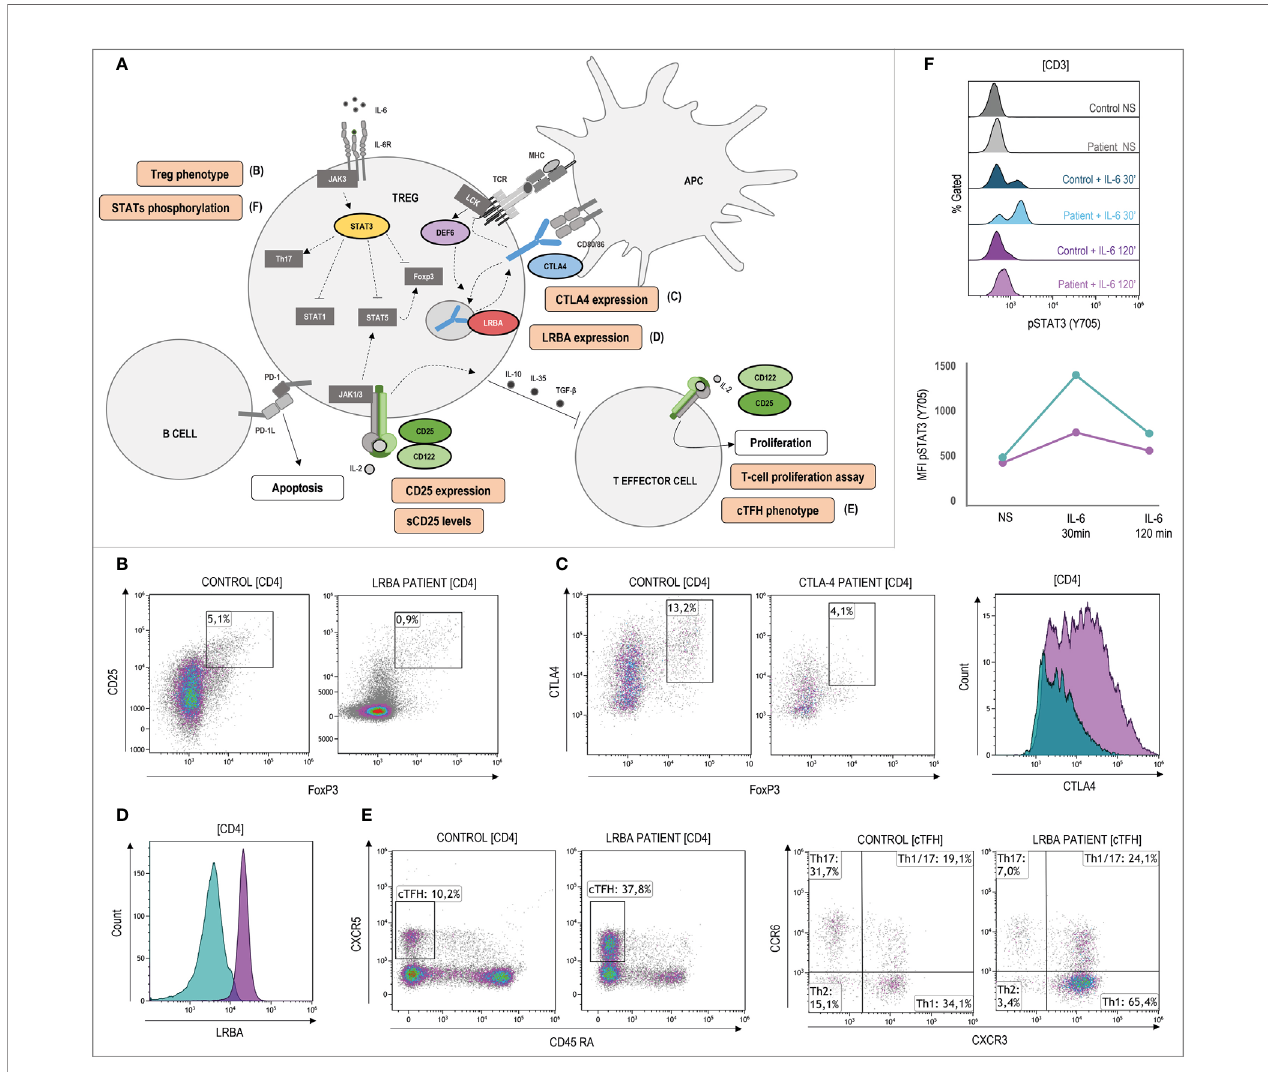
FIGURE 5 | Pathophysiology and functional assays through fl ow cytometry in ALPS-like patients with regulatory T-cells defect. (A) Schematic representation of the genetic defects (in color) and pathways identi fi ed in ALPS-like patients with Treg defect. Immunologic studies are outlined in orange. The letters in parentheses refer to the functional studies included in Figure 5. Altered Tregs levels and/or function is shown in patients with CTLA4, LRBA, DEF6, IL2RA and IL2RB de fi ciencies and gain of function of STAT3. (B) Decreased CD4+CD25+FoxP3+ Treg cells in a LRBA patient. (C) Lower CTLA4 levels in a patient with CTLA4 haploinsuf fi ciency (blue) in comparison with the healthy control analyzed (purple). (D) Decreased LRBA expression in CD4 T-cells of a patient with LRBA de fi ciency (blue) in comparison with the healthy control analyzed (purple). (E) Expansion of CD4+CXCR5+CD45RA- circulant follicular helper T cells (cTFH) and polarization to CCR6-CXCR3+ Th1 phenotype in a LRBA patient. (F) Hyperphosphorylation and delayed dephosphorylation of STAT3 (in tyrosine 705) induced by IL-6 in a patient with gain of function of STAT3 in comparison of the healthy control included. Line graph shows the median intensity fl uorescence of STAT3 phosphorylated in the STAT3 GOF patient (blue) and the healthy control (purple). NS, no